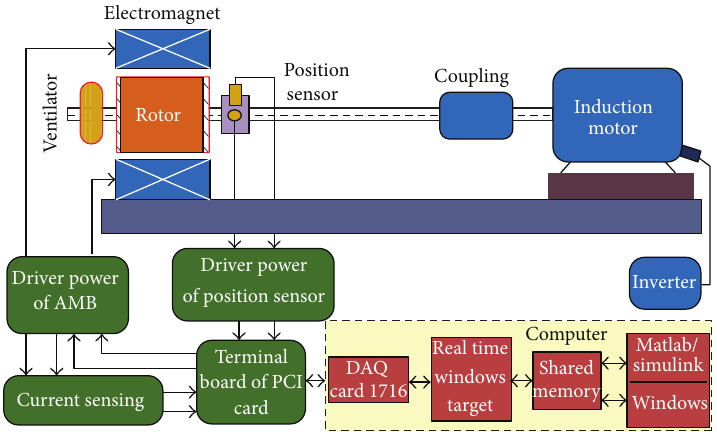
Figure 12: The experimental setup of the AMB system.